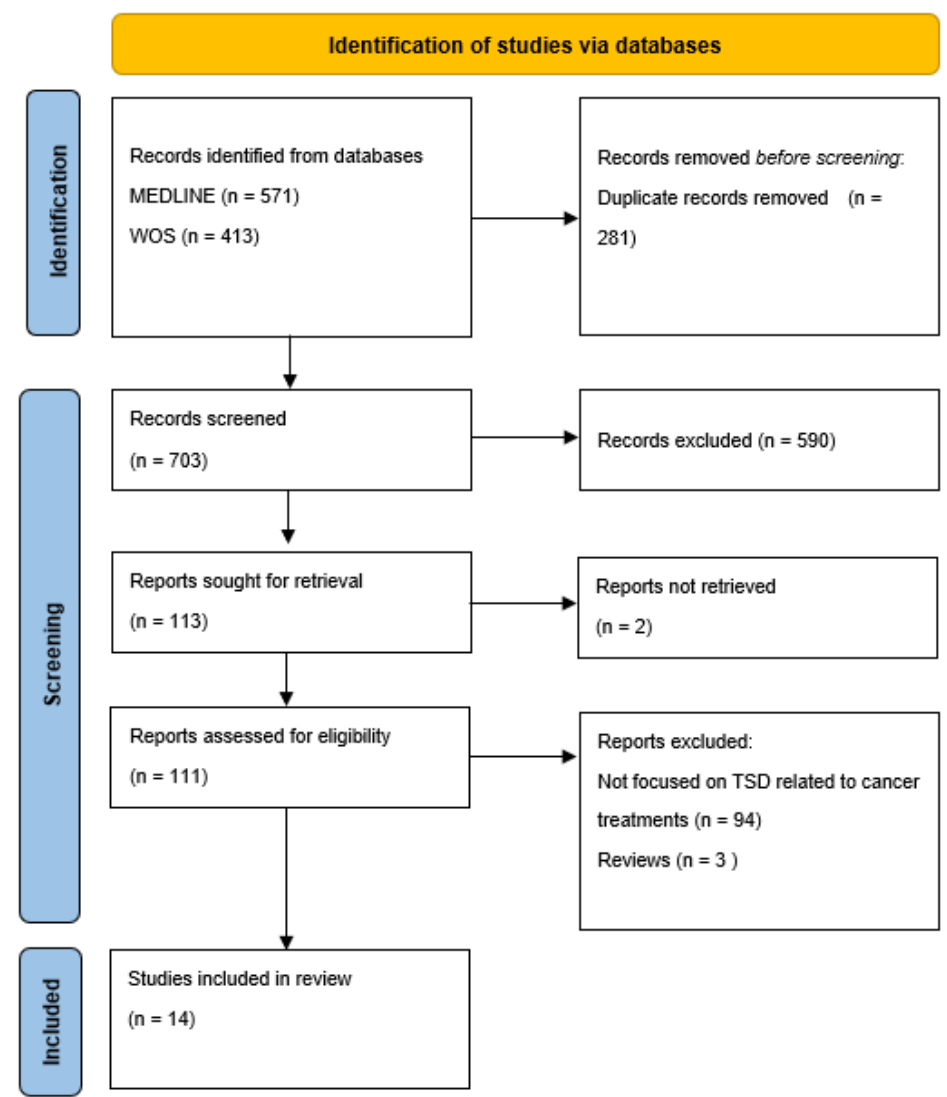
Figure 1. Flowchart of the data collection and selection process in accordance with PRISMA-ScR guidelines. Table 1. Characteristics of studies that evaluated cancer therapy-related dysgeusia. Ref.